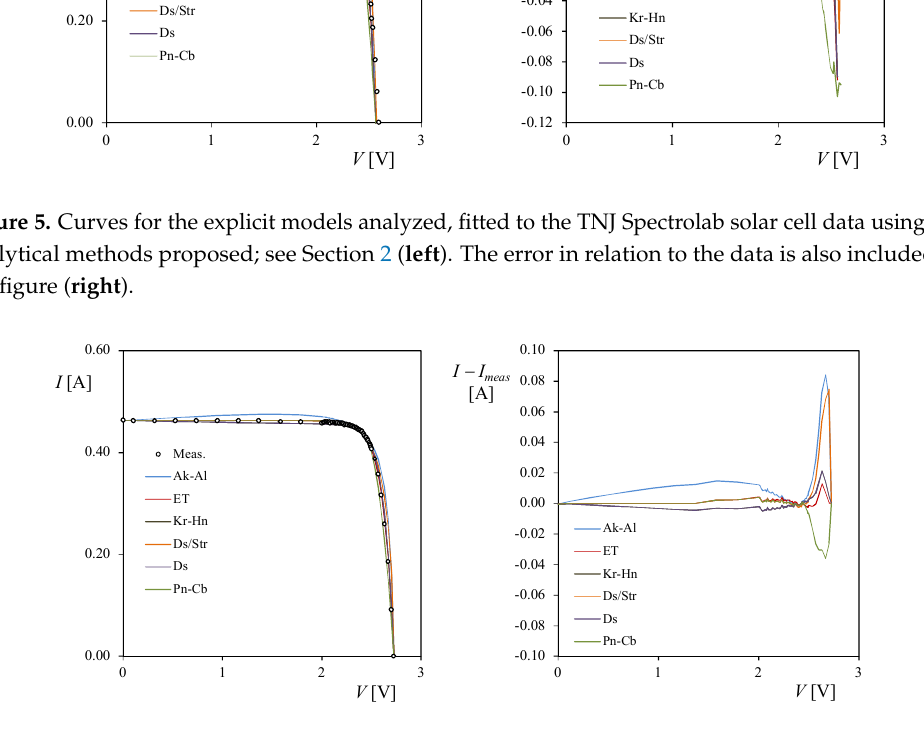
Figure 6. Curves for the explicit models analyzed, fitted to the ZTJ Emcore solar cell data using the analytical methods proposed; see Section 2 ( left ). The error in relation to the data is also included in the figure ( right ).